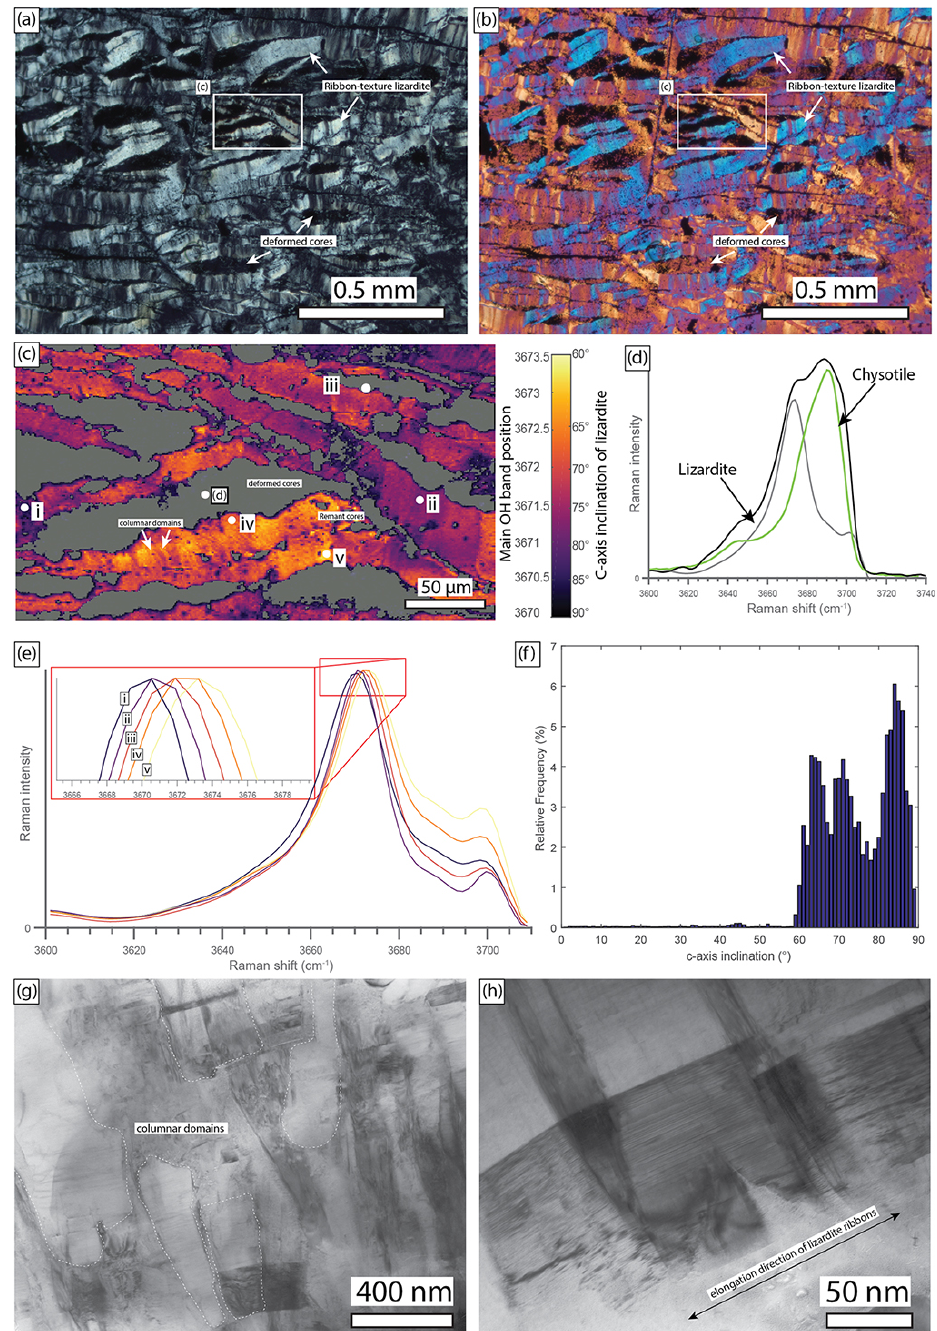
Figure 10. Raman spectroscopy mapping of the crystallographic orientation of lizardite in sample CV7a, a lizardite ribbon-textured serpenti- nite from eastern Elba, Italy. Thin section image of sample in (a) cross-polarised light and (b) cross-polarised light with a wave plate inserted. The mapped region is outlined in a white box. (c) Raman-based map displaying the inclination of the c -axis of lizardite. Grey regions with no data represent the cores of deformed mesh-textured serpentinite surrounded by mapped lizardite ribbon-textured serpentinite. The cores are characterised by a sub-resolution intergrowth of lizardite and chrysotile, as well as the abundant presence of magnetite. (d) Representative OH-region Raman spectrum for the deformed cores in (c) displaying a mixed spectrum of lizardite and chrysotile. (e) Representative spectra from the Raman map in (c) which demonstrate the shift in the main band in the OH region for lizardite, which can be related to the inclination of the c -axis of lizardite. (f) Histogram of the c -axis inclination for every measured point. (g) TEM image of sample CV7a which shows columnar lizardite crystals with a large base and a thinner “apex”. (h) TEM image of sample CV7a which shows columnar lizardite crystals oriented at a large angle to the elongation direction of the